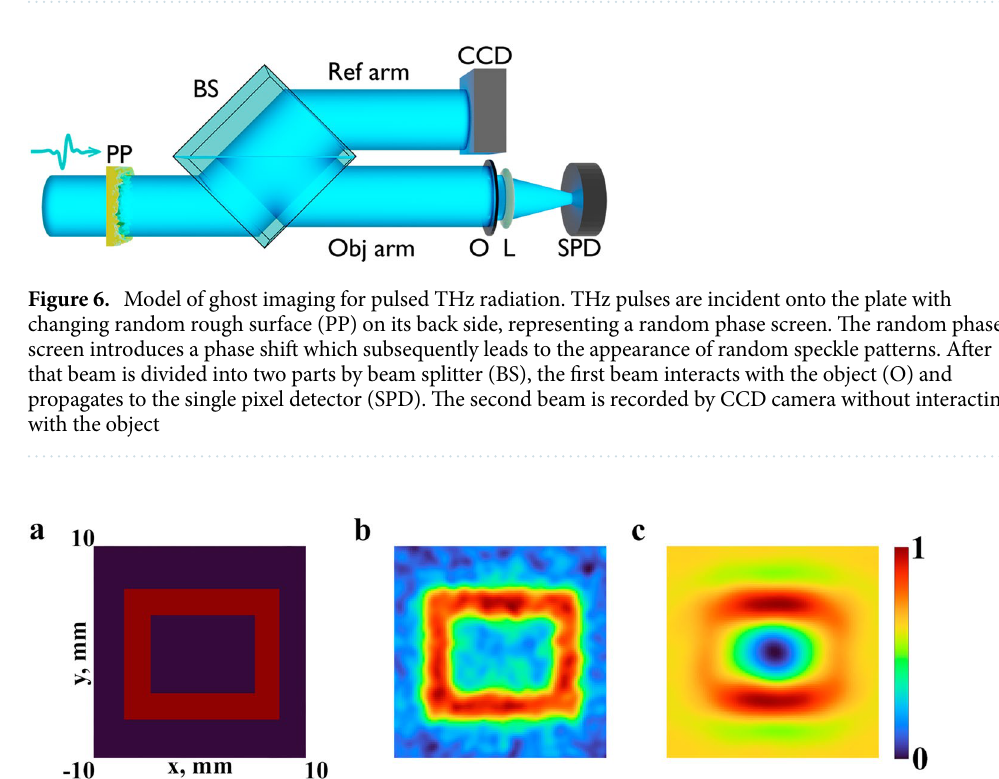
Figure 5. ( a ) The timeform of experimental THz pulse. ( b ) Spectrum of experimental THz radiation